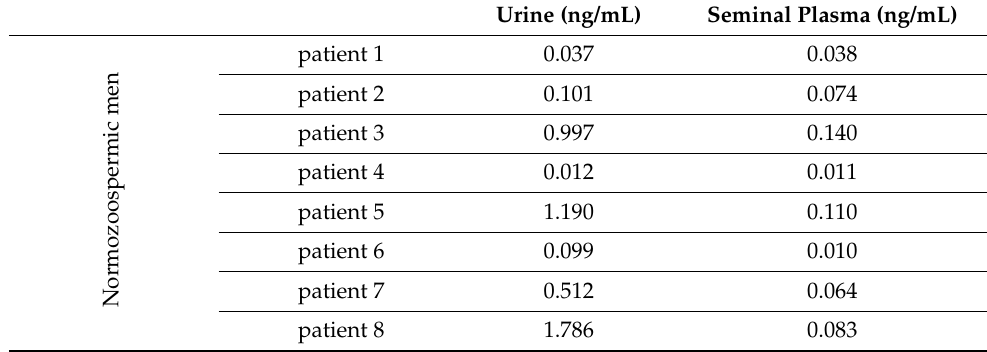
Table 2. Detection of bisphenol S (BPS) in all the observed patients in urine and in seminal